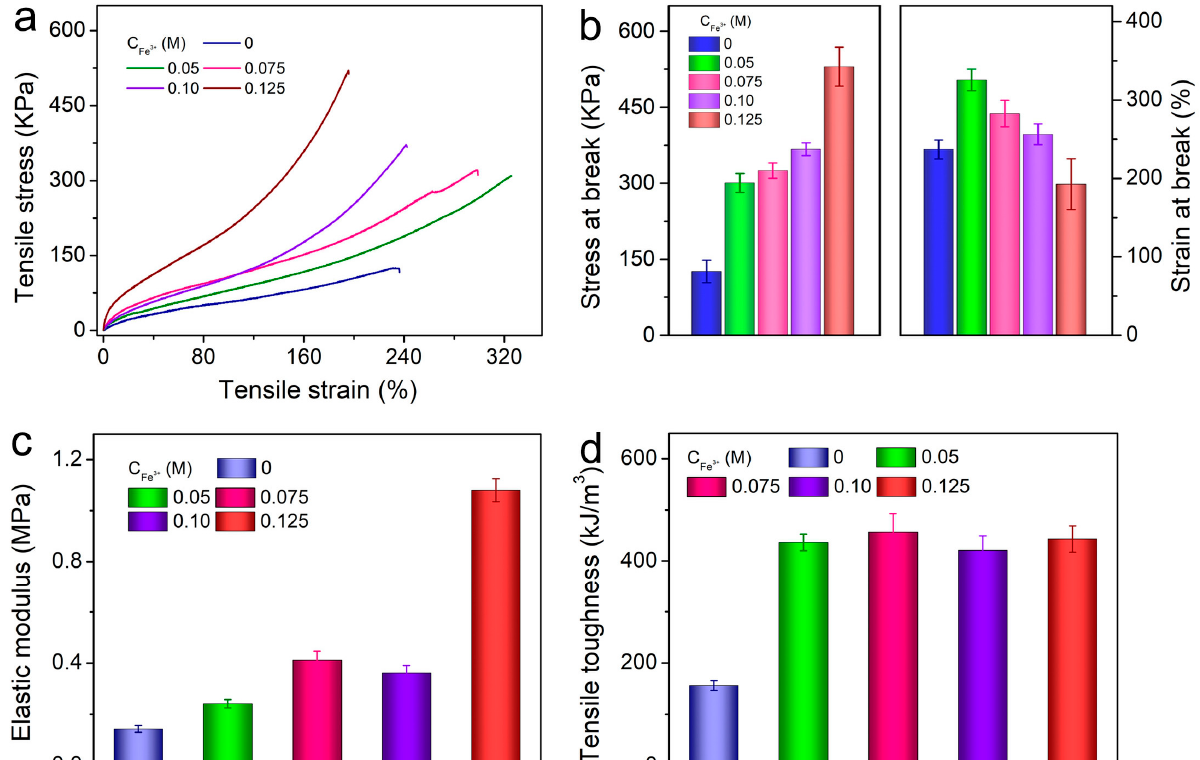
Figure 5. ( a ) Tensile stress-strain curves of PZ-PAA bi-layer hydrogels coordinating at different Fe 3+ concentrations. ( b ) Stress and strain at break, ( c ) elastic modulus, and ( d ) tensile toughness of PZ-PAA@Fe 3+ bi-layer hydrogel.